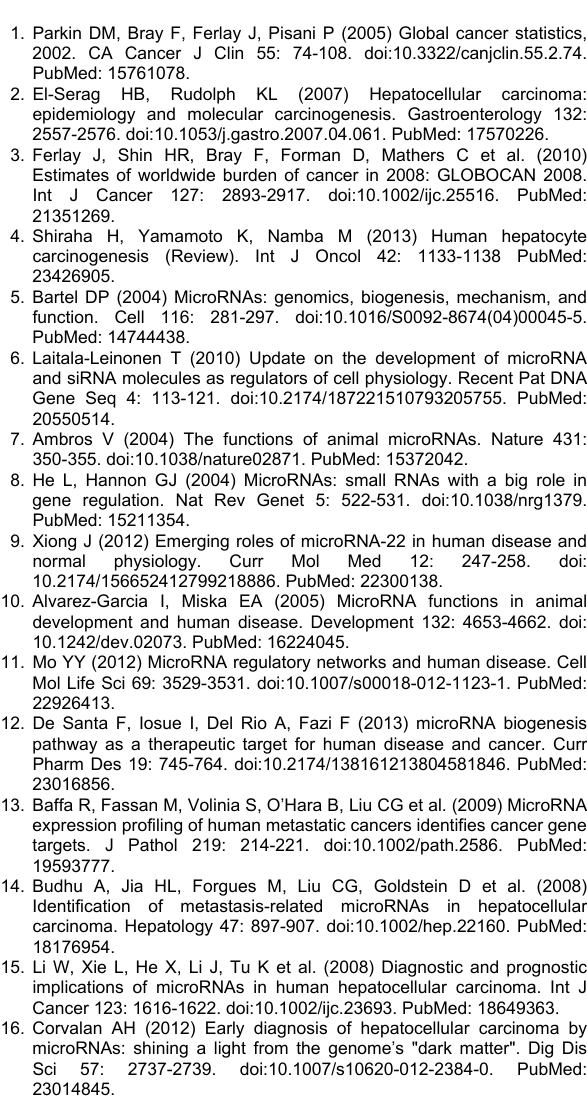
Figure S3. Upregulation of ERManI promotes proliferation of hepatoma cells. A . Growth curve of PLC/PRF5 cells 72hr after transfection with empty vector or ERManI cDNA. Error bars represent the standard error of mean. B. Growth curve of HepG2 cells